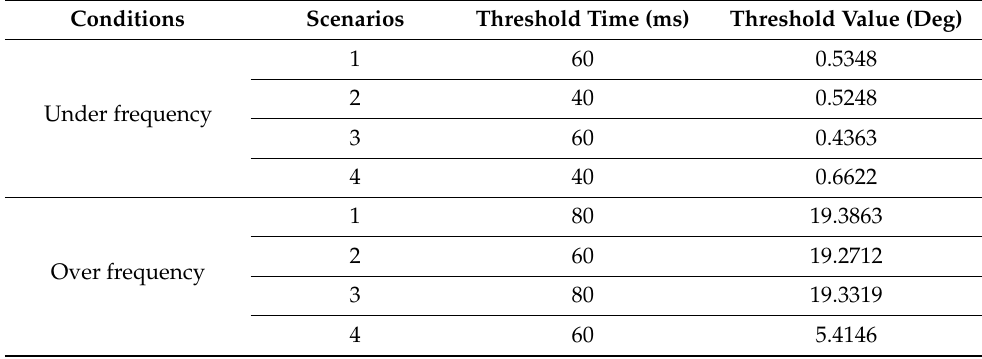
Table 3. Results of the proposed unintentional island threshold